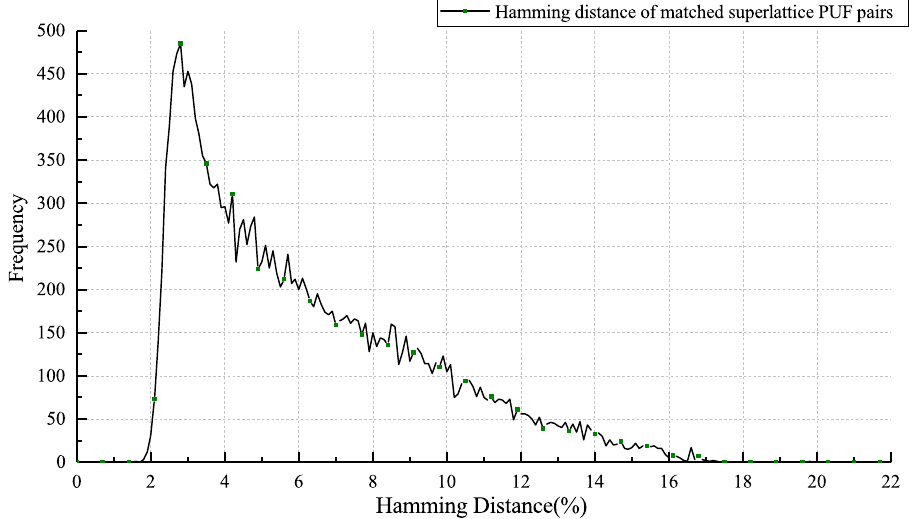
Figure 3. The Hamming distance of 20,000 blocks from matched superlattice PUF pairs. And the block-length is